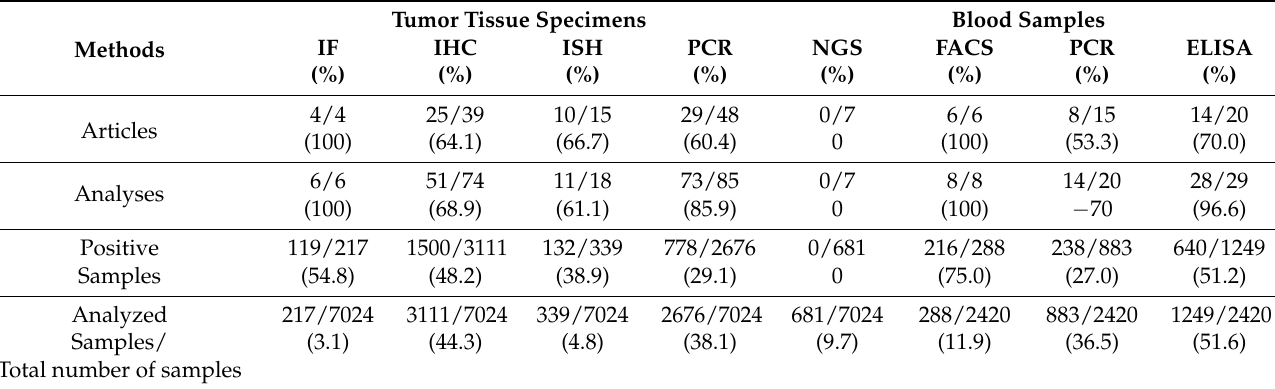
Table 2. Summarized results reported from published studies with or without detection of the HCMV in clinical samples obtained from GBM patients using IF, IHC, ISH, PCR, ELISA, NGS and FACS methods.